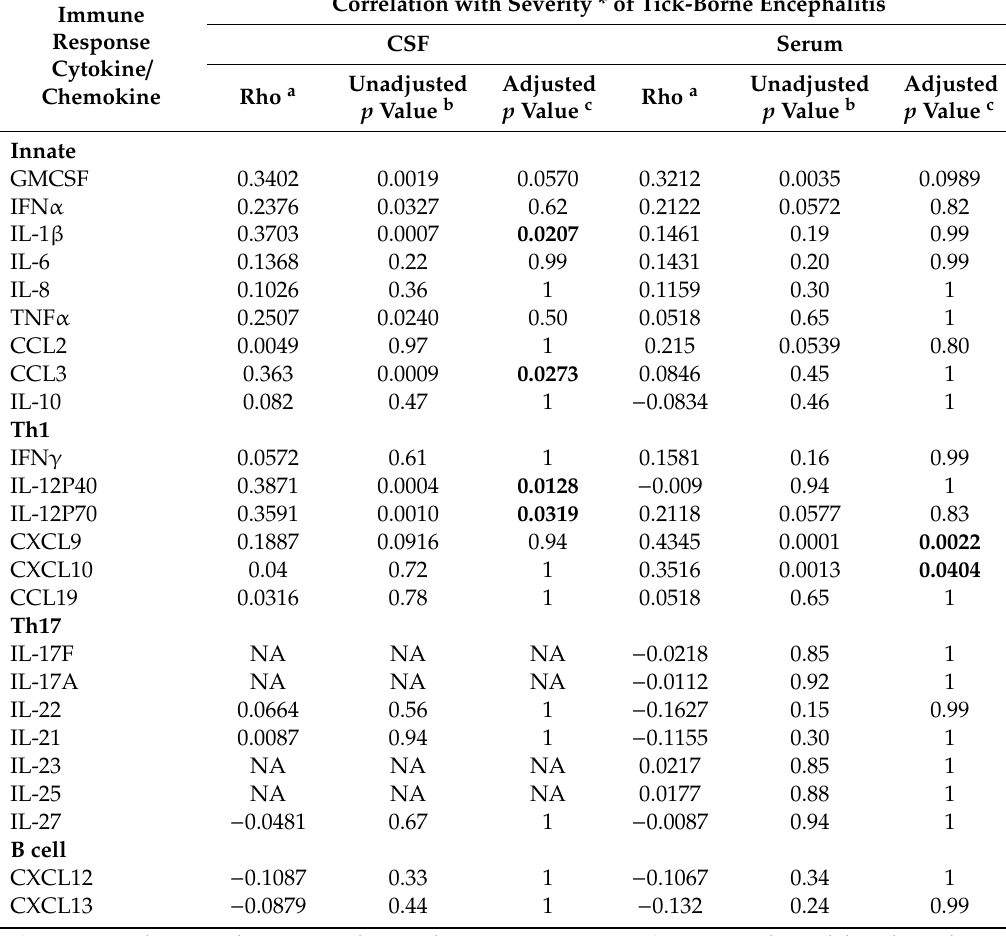
Table 4. Correlation of Cytokine and Chemokine Levels in Serum or Cerebrospinal Fluid and the Severity of Tick-borne